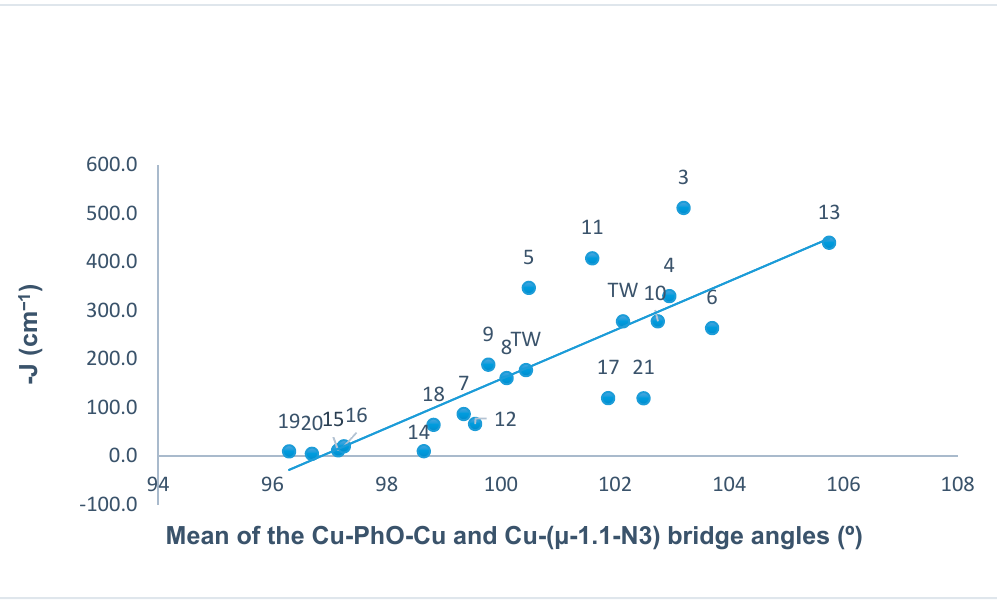
Figure 18. Plot of the antiferromagnetic interaction ( − J) vs. the Cu---Cu distance (d) in dinuclear ( μ - phenolate/ μ -azido bridged) copper(II) complexes. 2.5. Powder X-ray Diffraction Studies In an attempt to characterize the bulk powder, the XRD patterns of 1 , 3 and 5 were collected. (Figures S3–S5). The XRD patterns were collected and compared to the calculated pattern generated from the single-crystal X-ray structure [131]. For 3 and 5 , the form of the diffraction curve for the